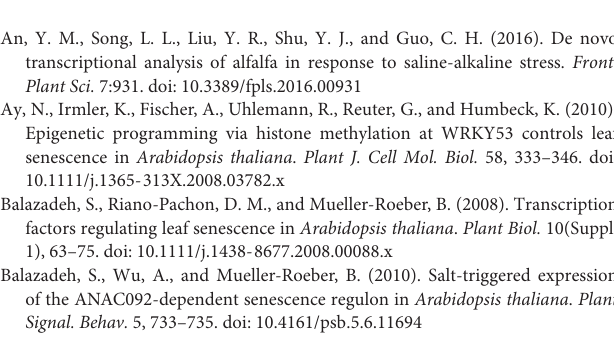
Supplementary Table 3 | Differentially expressed genes (DEGs) at days 2, 4, and 6. Supplementary Table 4 | 985 SAGs and 1,180 genes are obtained using the Venn diagram. Supplementary Table 5 | TF family analysis data. Supplementary Table 6 | KEGG pathway enrichment analysis in individual cluster. Supplementary Table 7 | 169 DEGs related to ion transport. Supplementary Table 8 | Responses of detached leaves to salt stress and alkali stress. Supplementary Table 9 | Carotenoid biosynthesis and glutathione